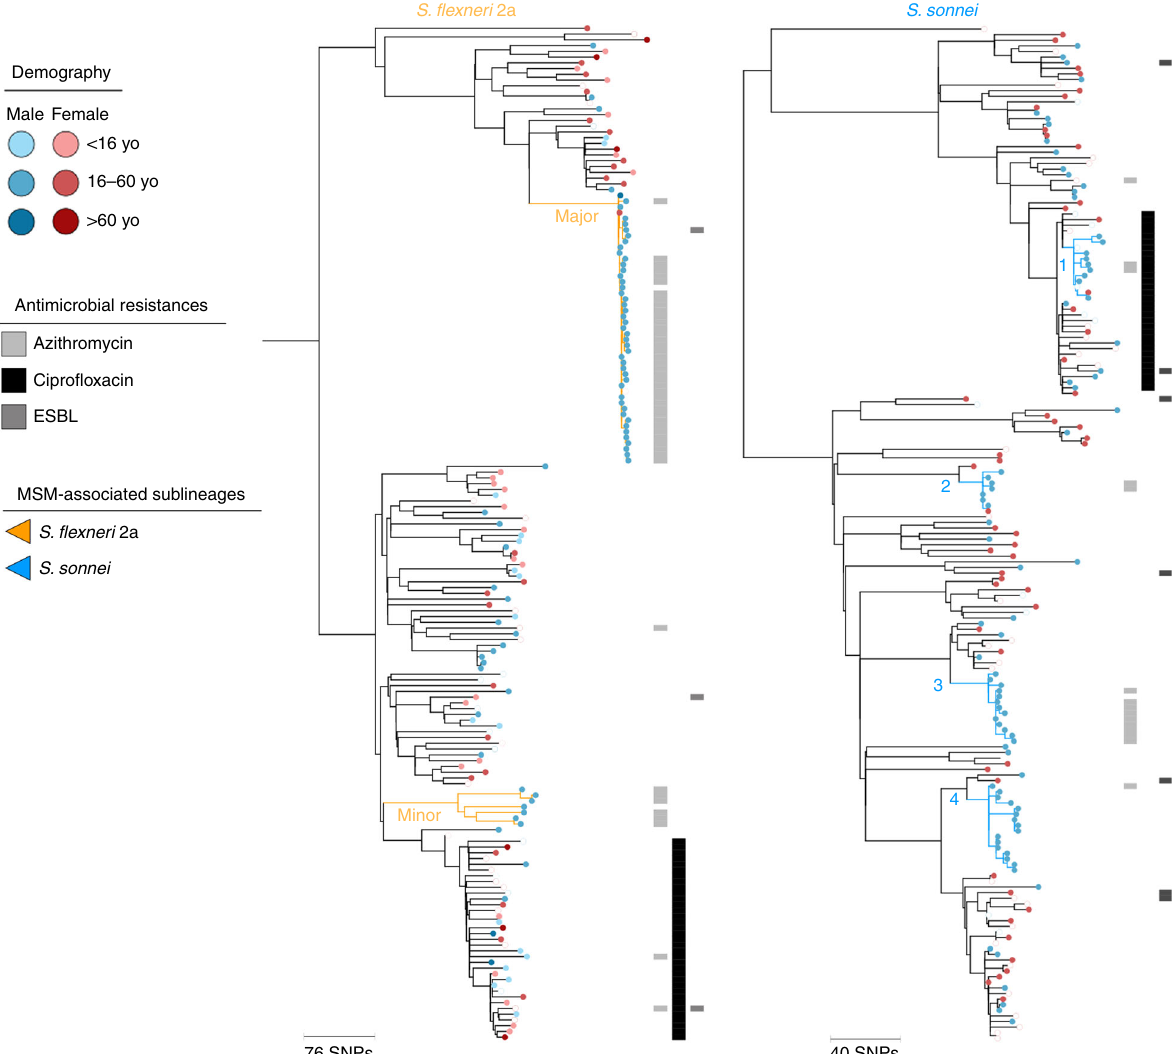
Fig. 1 MSM-associated sublineages and antimicrobial resistance associations in context. The midpoint rooted maximum likelihood phylogenetic trees are shown for PG3 of S. fl exneri 2a and Lineage III of S. sonnei . Scale bars in single nucleotide polymorphisms (SNPs) are shown below each phylogeny. Patient demography of isolates is shown overlaid on tips according to the inlaid key with circles of patients reporting recent travel to regions endemic for shigellosis being hollow. MSM-associated sublineages are labelled and coloured according to the inlaid key. Anticipated resistance phenotypes for azithromycin, cipro fl oxacin (only triple QRDR mutants), and ESBL are shown in adjacent